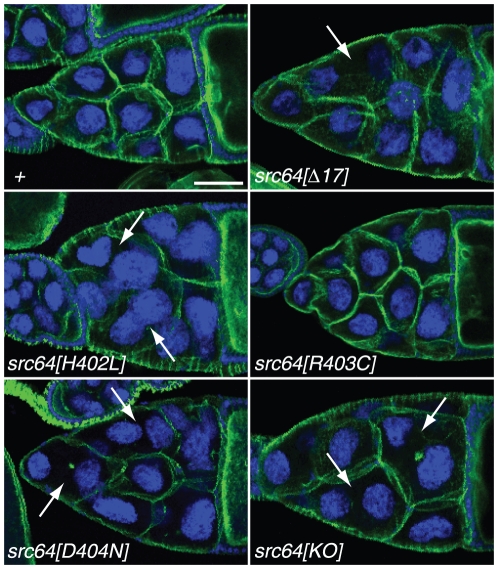
Nurse cell fusion defects in src64 mutant egg chambers.Egg chambers are stained with phalloidin (green) and Hoechst (blue). Partial confocal projections are shown. Nurse cell fusion (arrows) occurs in src64Δ17, src64H402L, src64D404N and src64KO mutants. Nurse cell fusion does not occur in src64R403C mutants. Scale bar, 50 µm.